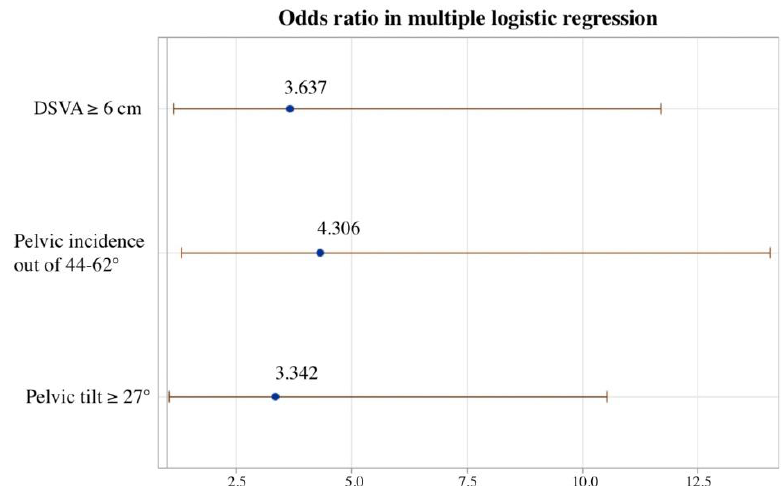
* Statistically significant. Data are presented as number (percentage). SVA: sagittal vertical axis; DSVA: horizontal distance between fracture center to C7 plumb line; PT: pelvic tilt; PI: pelvic incidence; OR: odds ratio; CI: confidence interval.